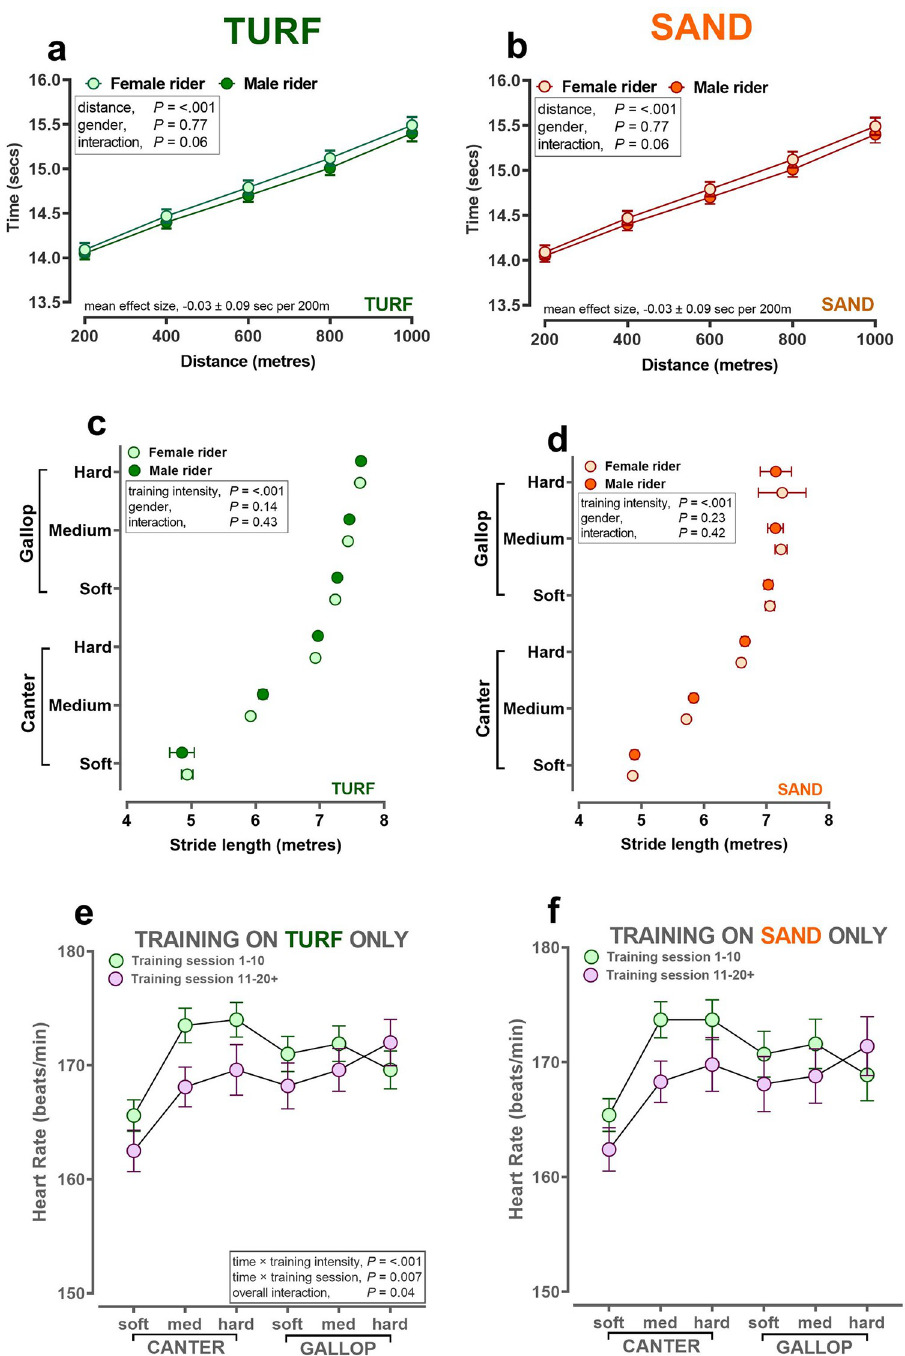
Fig 2. Speed, stride and influence of multiple training sessions on different track surfaces by sex of work rider. a-f: Values are predicted mean ± S.E.M. for continuous data recorded by ‘Equimetre’ in a cohort of racehorses in Australia (n = 130 different racehorses, n = 1,754 different training sessions). Data were available throughout the year. Training intensity (soft/med/hard canter; soft/med/hard gallop) was derived from calculating sextiles of the fastest furlong (200m interval) for the overall dataset. The statistical model generated predicted means ( ± S.E.M.) with the pre- specified interaction, training intensity × rider sex (or training session, e,f ) fitted last after inclusion of rider registration status and track surface as fixed effects, HorseID and rider name as random effects, since both horses and riders completed multiple sessions. All data analyses were conducted using Genstat v20 (VSNi, UK) and graphs produced using Graphpad Prism v9.0 (La Jolla,